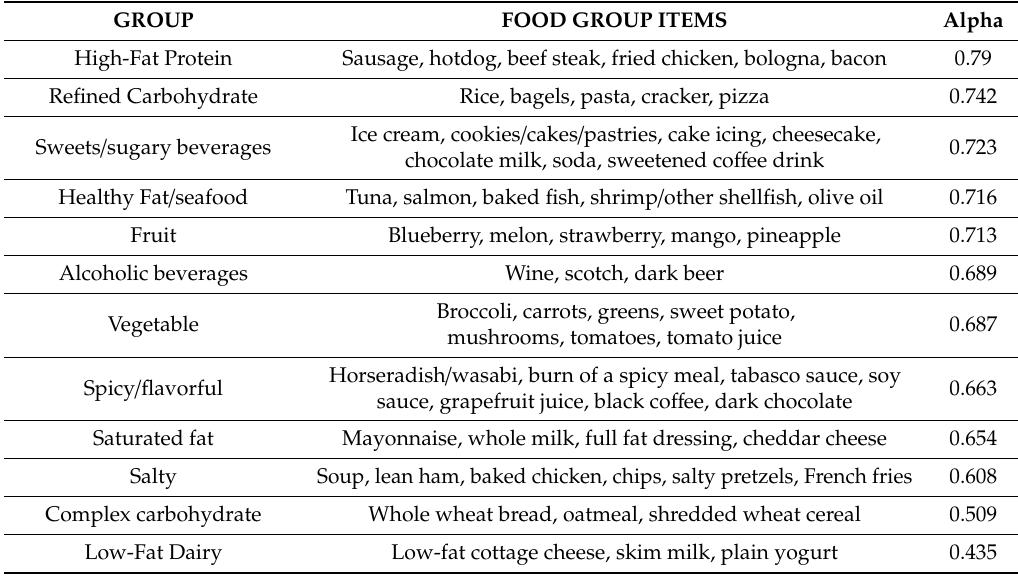
Table 1. Food groups generated from a food liking survey, listed from most to least internally consistent assessed by the Cronbach’s